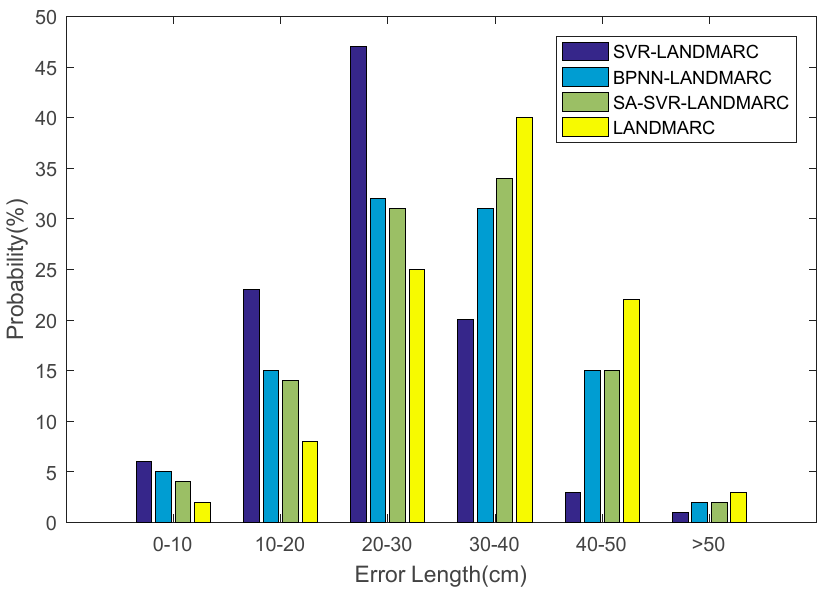
Figure 7. Location map of error rate distribution.